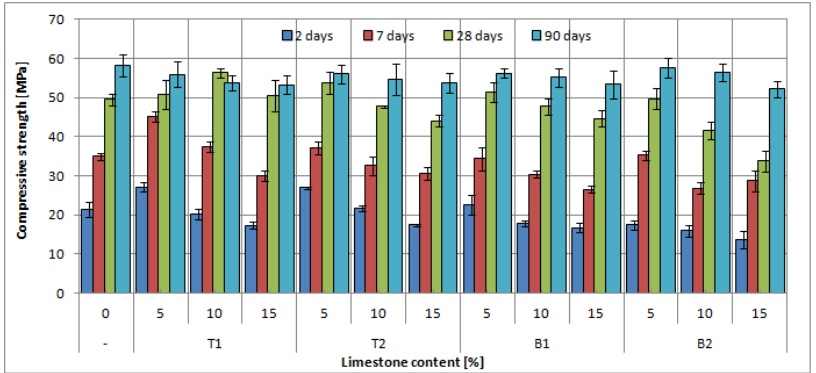
Figure 9. Compressive strength of blended slag-limestone cements made of CEM II/A-S 52.5N.